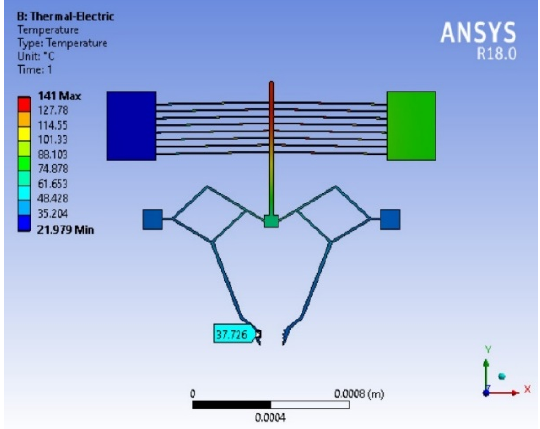
Figure 13. Temperature distribution of IMG2.